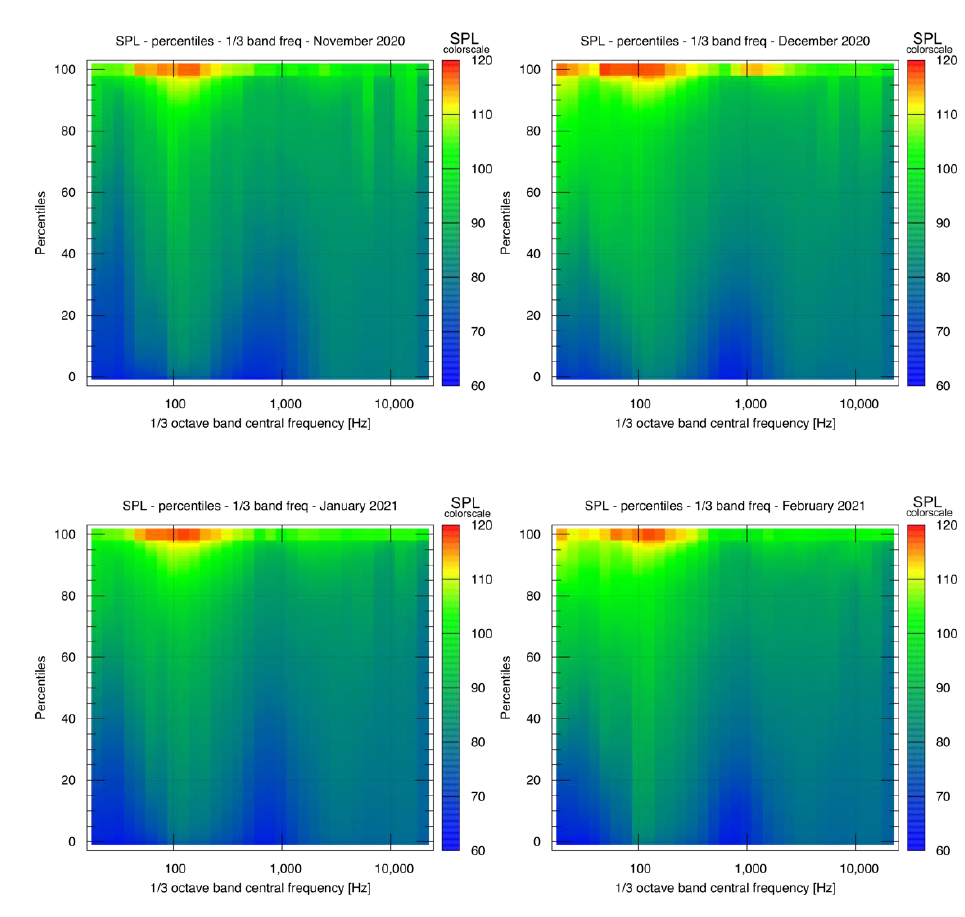
Figure 14. Autocorrelation of the cumulative SPL during the period 11/21/2020 and 2/13/2021.